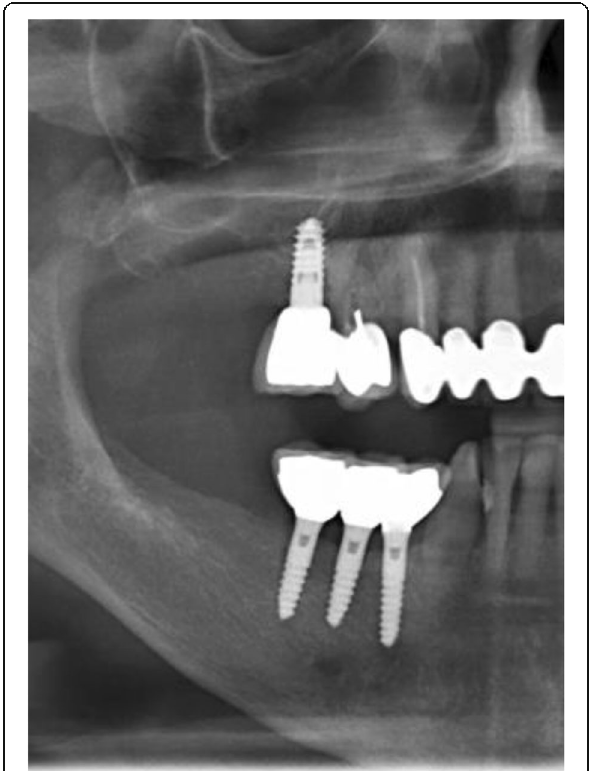
Fig. 11 Radiological follow-up of the same patient 8 years post-OP